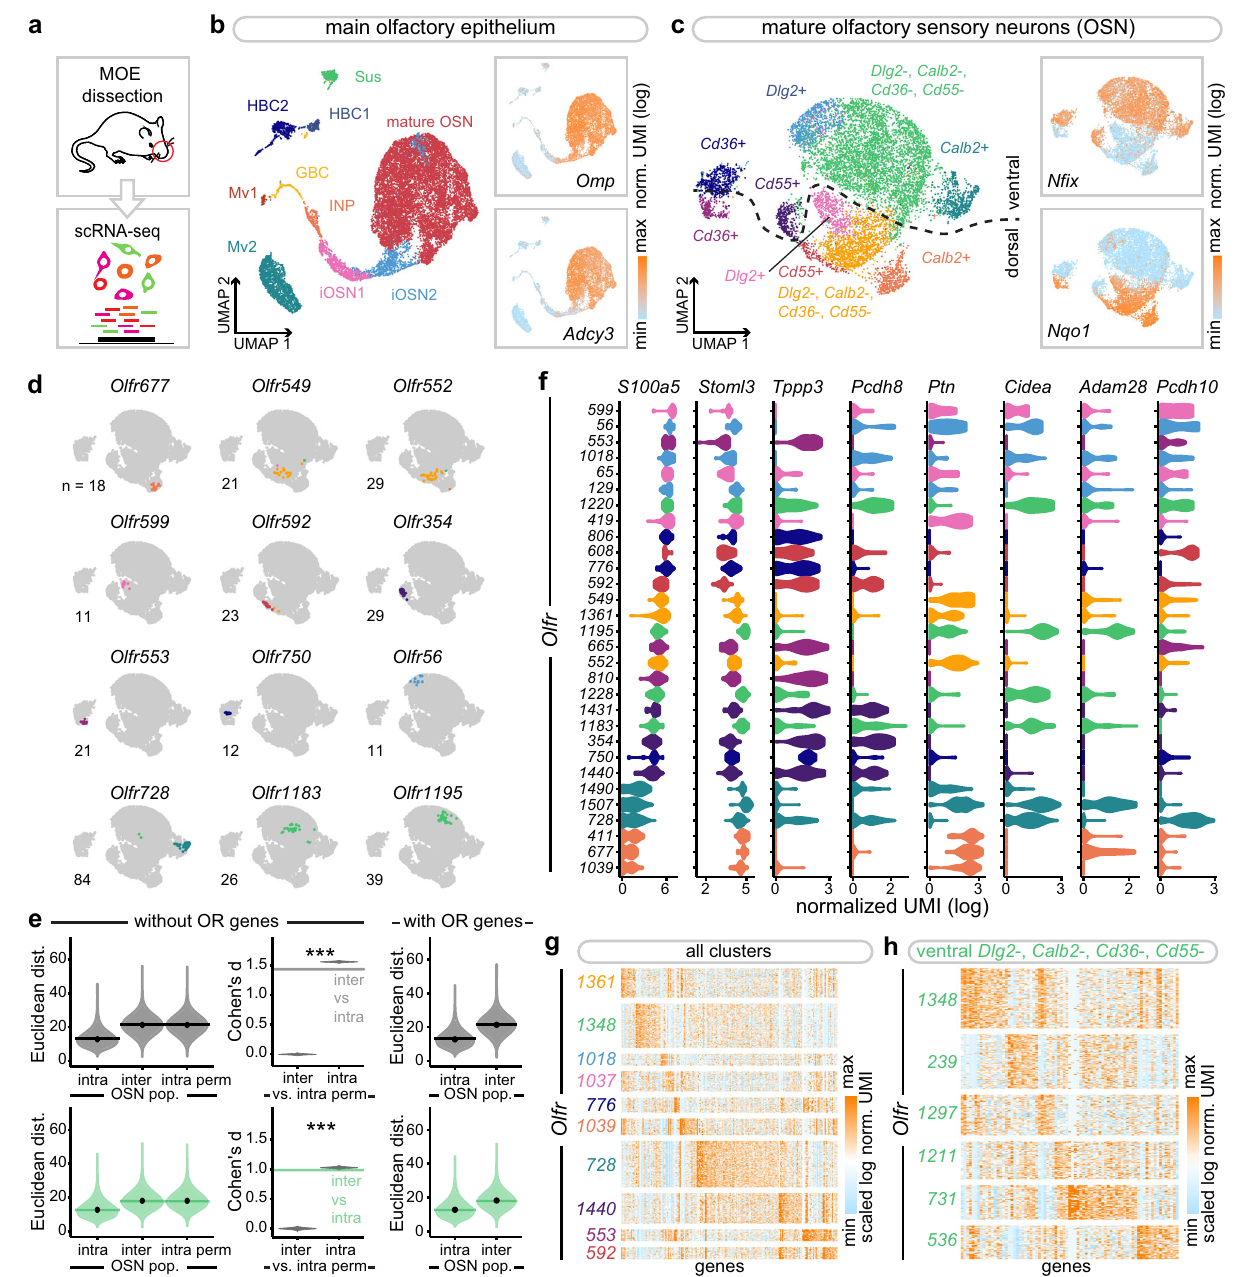
(Fig. 1g, h). At rest, that is without active olfactory stimulation, a transcriptomic code thus characterizes each OR-de fi ned